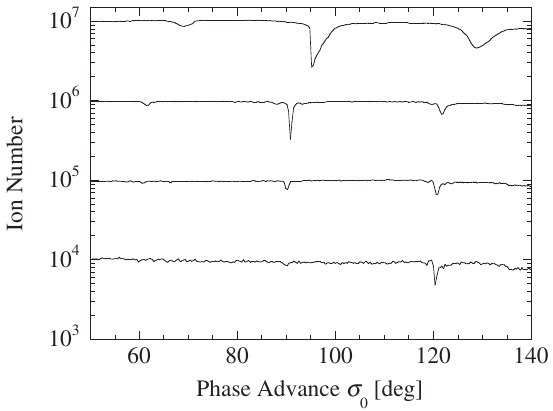
FIG. 6. Ion-loss distributions measured in S-POD with the sinusoidal focusing potential. Each of the four curves consists of 237 data points obtained from 237 independent measurements over the range 50 ° ≤ σ 0 ≤ 140 ° at the same initial ion number ≈ 10 4 , 10 5 , 10 6 , or 10 7 ). The storage period of ions in the ( N ion LPT is fixed at 10 ms in all four cases. It takes us only less than 40 minutes to complete 237 measurements.